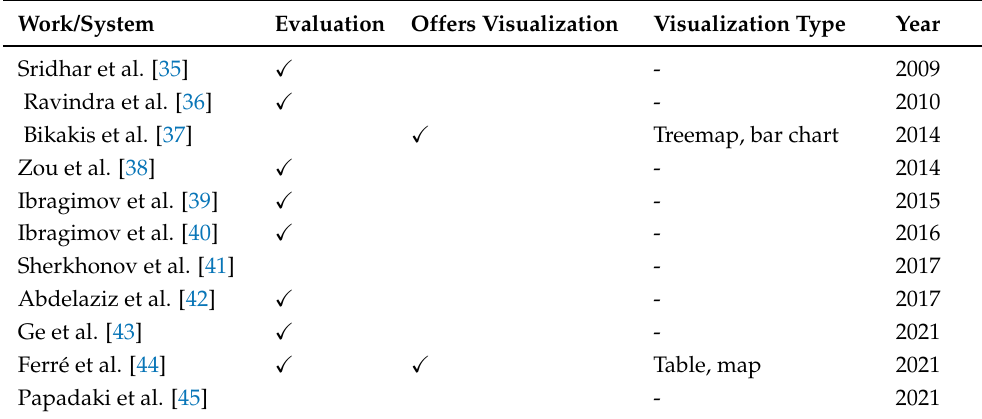
Table 1. Overview of Approaches and Systems for Category C1 (analytical queries A).